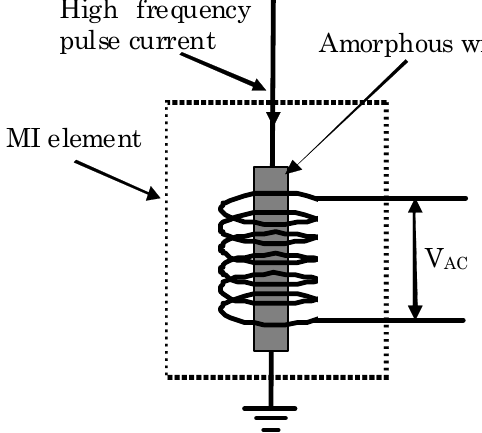
Figure 1. The magneto-impedance (MI) element composed of amorphous wire with an electrical connection between the amorphous and the AC high-frequency current.